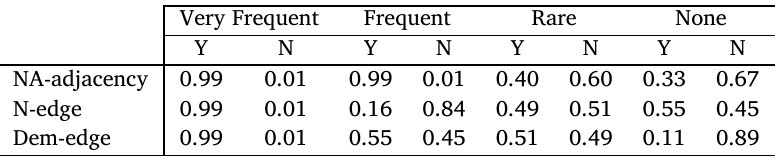
Percent precision, recall and F measure by frequency class of token-based Naive Bayes classifier for Cysouw’s